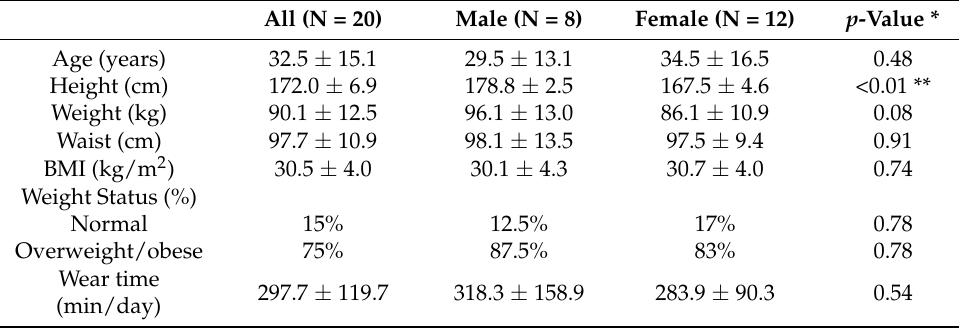
Table 2. Participant characteristics by gender, mean ± standard